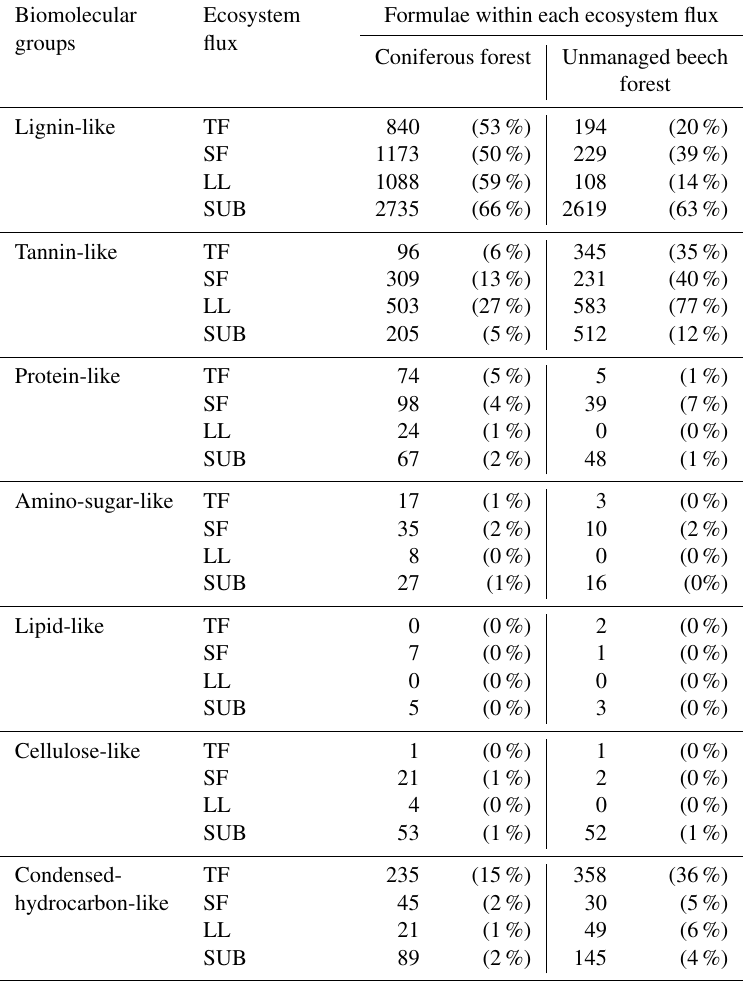
Table 3. Number of formulae (relative shares) assigned to major groups of biomolecules according to Sleighter and Hatcher (2007) obtained from FT-ICR mass spectra of DOM samples from ecosystem fluxes of coniferous (pine) and unmanaged beech forest from the Schorfheide. TF: throughfall; SF: stemflow; LL: litter leachate; SUB: subsoil